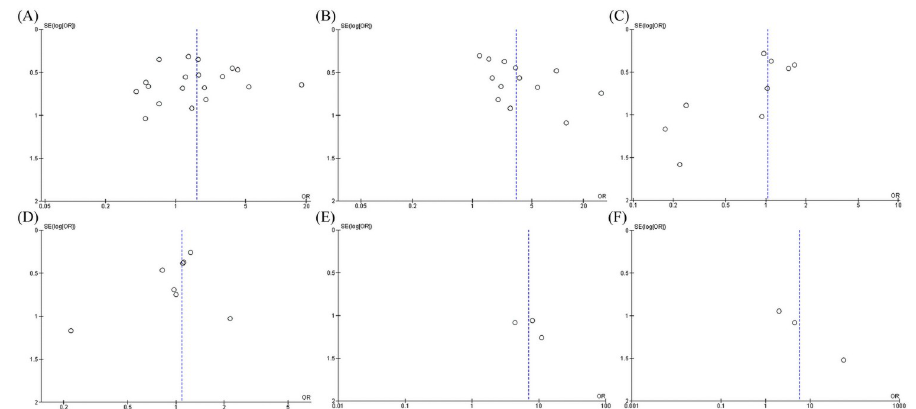
Fig 5. Funnel plot of the meta-analysis of (A) OS rate between allo-HSCT versus CMT only, (B) DFS rate between allo-HSCT versus CMT (C) OS rate between allo-HSCT versus auto-HSCT (D) DFS rate between allo-HSCT versus auto-HSCT (E) OS rate between auto-HSCT versus CMT (F) DFS rate between auto-HSCT versus CMT only.